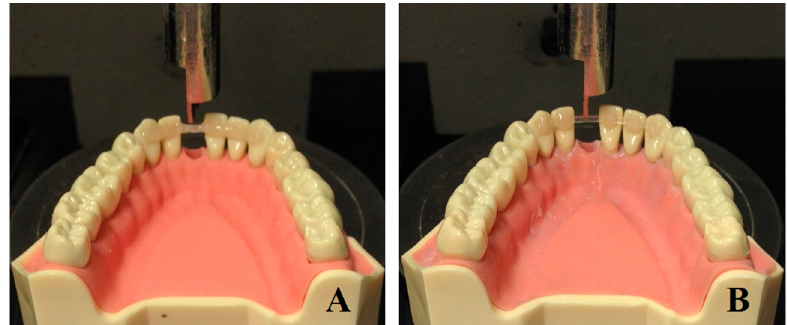
Figure 1. FRC tested with the conventional Full-bond technique ( A ) and with the experimental Spot-bond technique ( B ).